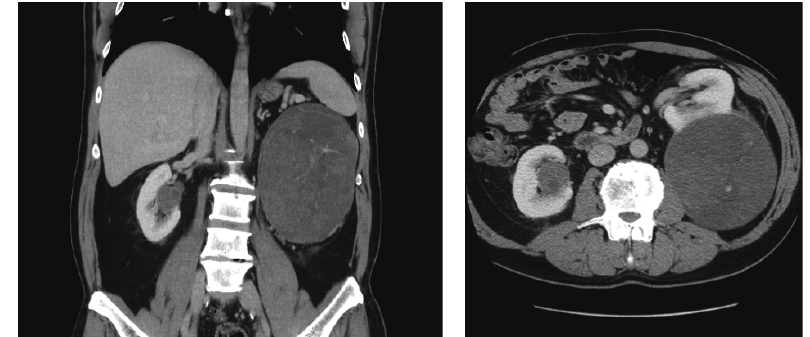
Figure 1: Infused axial and coronal CT abdominal images of patient 1.